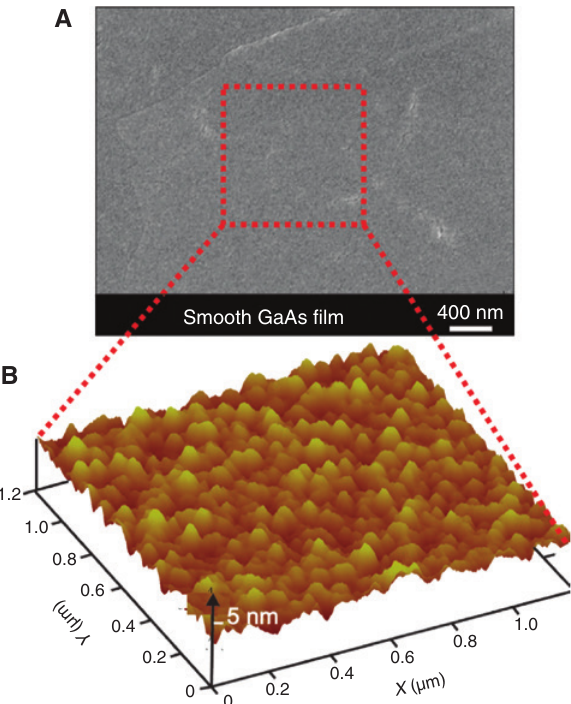
Figure 3: (A) SEM image of grown GaAs with Ga pregrown on multi- layer graphene buffer layer. The surface shows smooth morphology, which is confirmed using (B) atomic force microscopy image. The measured root mean squared (RMS) roughness is around 0.6 nm with peak-to-peak value of 3 nm